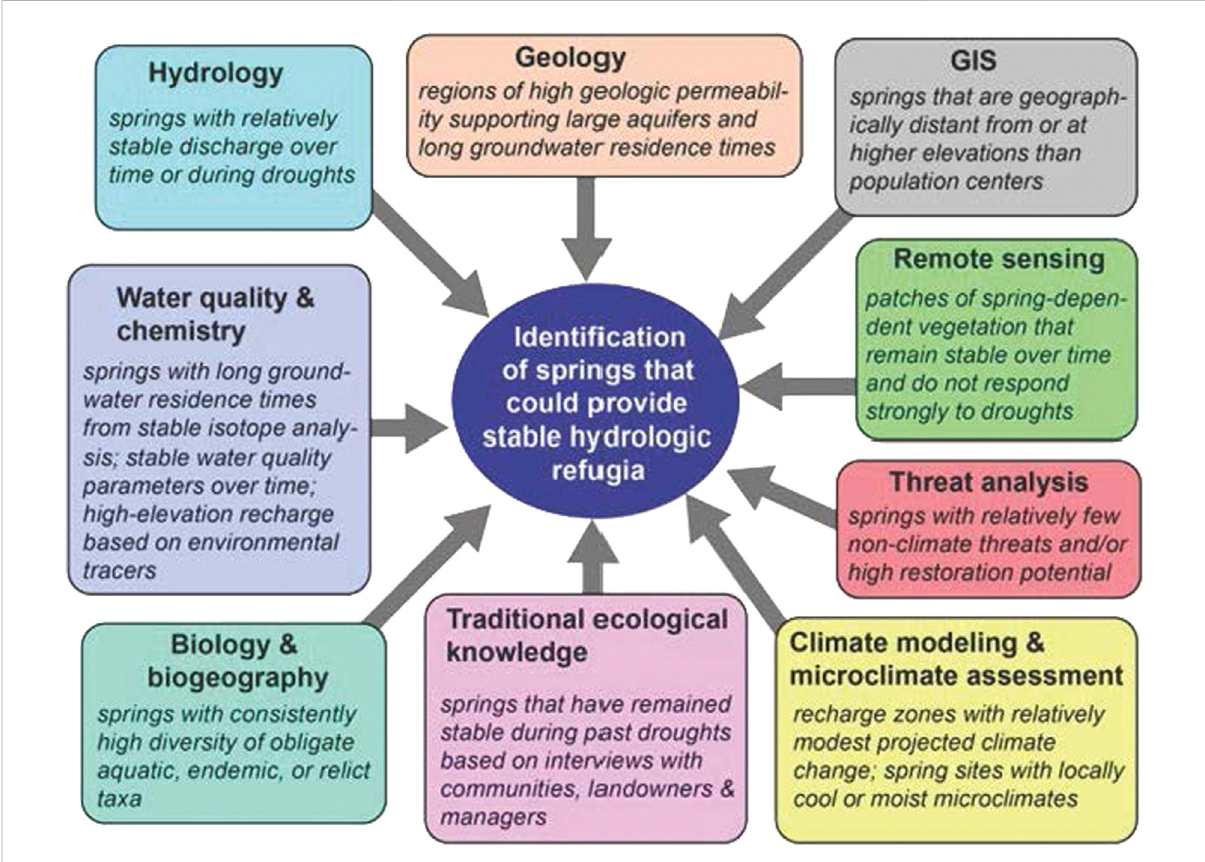
FIGURE 1 Potential lines of evidence for evaluating the ecohydrological similarity of springs in water-limited areas from Cartwright.